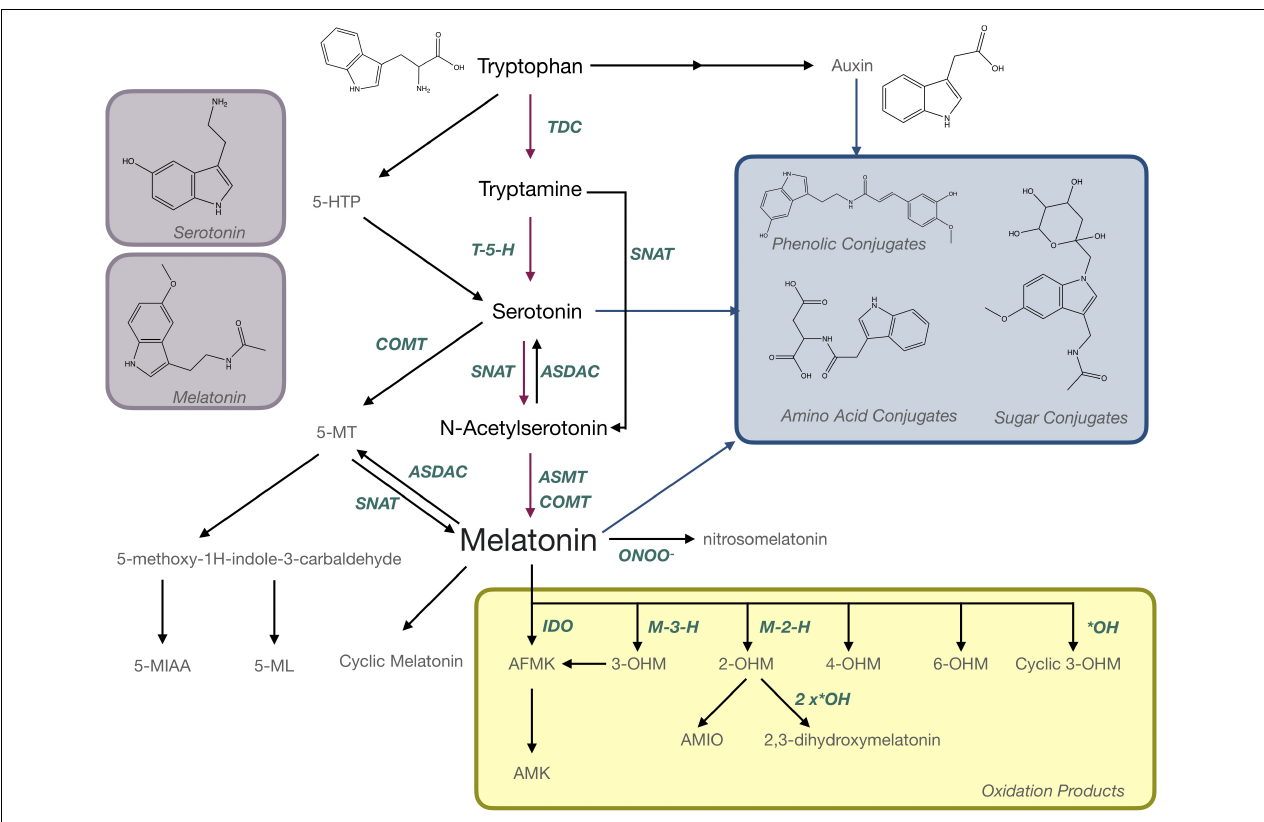
FIGURE 5 | Biosynthesis and metabolism of melatonin in plants. AFMK, N-acetyl-N-formyl-5-methoxykynuramine; AMIO, 3-acetamidoethyl-5-methoxyindolin-2-one; AMK, N-acetyl-5-methoxykynuramine; ASDAC, N-acetylserotonin deacetylase; ASMT, N-acetylserotonin-O-methyltransferase; COMT, caffeic acid-O-methyltransferase; 5-HTP, 5-hydroxytryptophan; IDO, indoleamine 2,3-dioxygenase; M-3-H, melatonin 3-hydroxylase; M-2-H, melatonin 2-hydroxylase; 5-MIAA, 5-methoxyindole-3-acetaldehyde; 5-ML, 5-methyoxytryptophol; 5-MT; OHM, hydroxymelatonin; SNAT, serotonin N-acetyltransferase; TDC, tryptophan